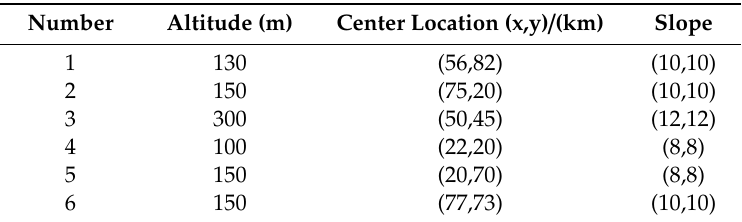
Table 8. Model parameters of peaks.